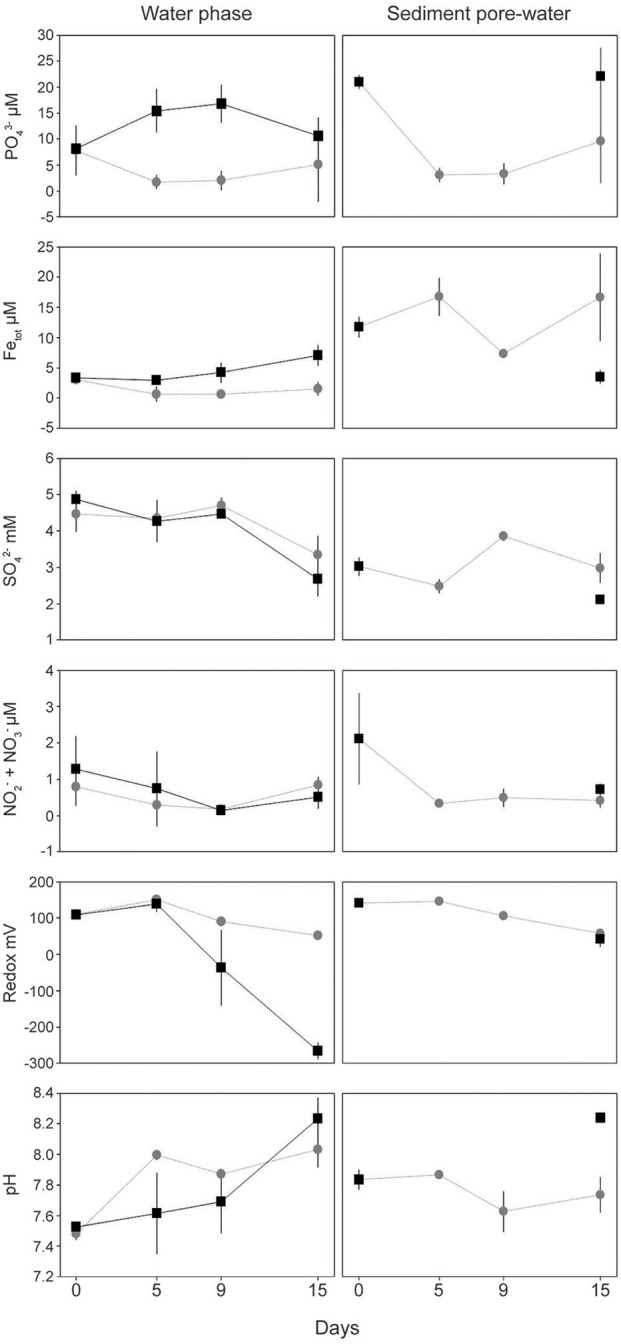
Chemical data from the field (sediment day 0) and laboratory incubations. Water phase and top 1 cm sediment pore-water data are shown on the left and right side, respectively. Gray circles denote the “turned oxic” treatment while black squares denote “turned anoxic.” All values are averages of biological replicates ± 1 SD. Replicates for the “turned oxic” water phase are as follows: day 0 and 5 (n = 10), day 9 (n = 7), and day 15 (n = 4) while the “turned anoxic” were n = 3 for all samples except day 15 that was n = 2. Replicates from the sediment surface are all averages of triplicates except “turned oxic” day 15 (n = 4) and “turned anoxic” were sliced at the end of the incubation after 15 days.